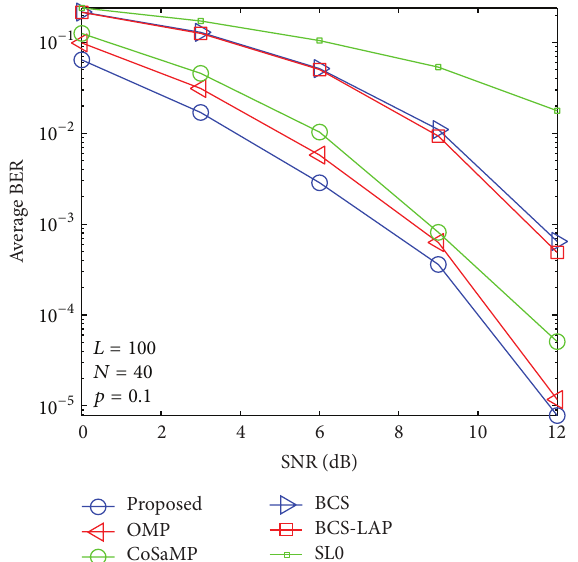
Figure 13: Computational complexity comparison via CPU time when 𝑝 1 = 0.1 and 𝑁 = 20